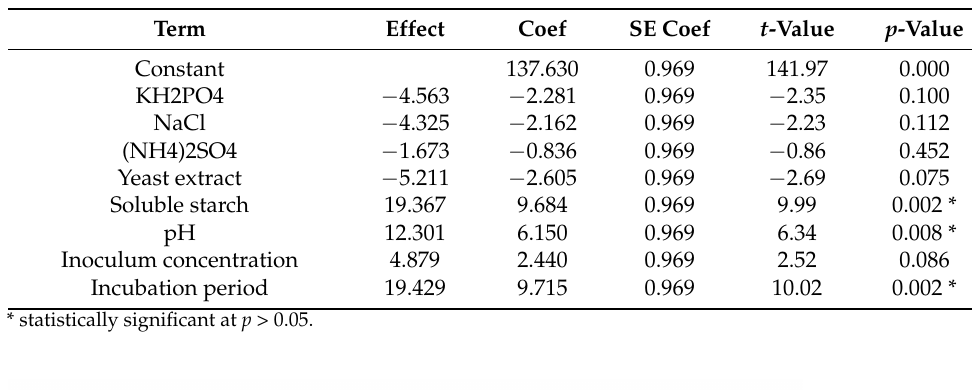
Table 3. ANOVA of PBD model for amylase yield (coded units).